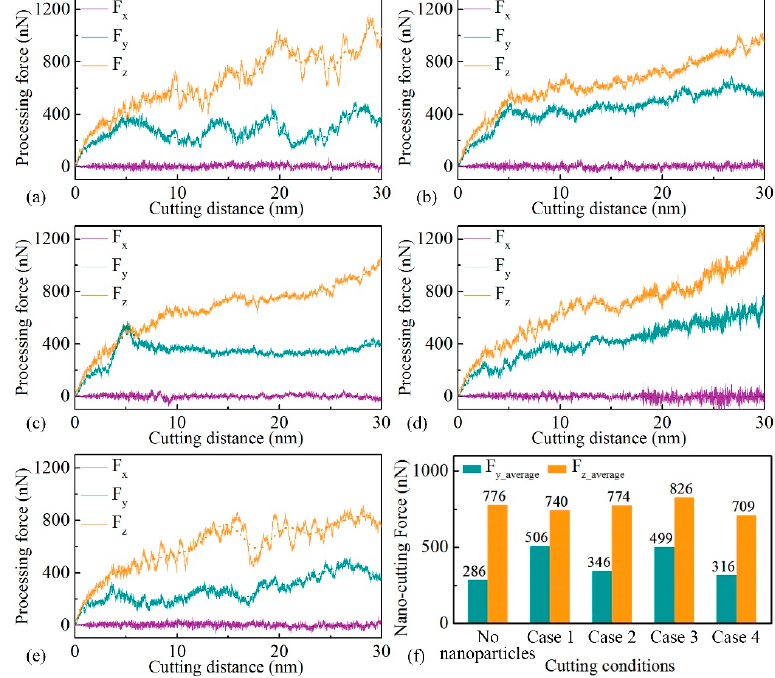
Figure 6. Evolution of the nano-cutting force of the workpiece with no NPs ( a ), with NP for ∆ D = 4 nm ( b ), 2 nm ( c ), 0 nm ( d ), and − 5 nm ( e ), and the mean nano-cutting force at x- and y-directions ( f